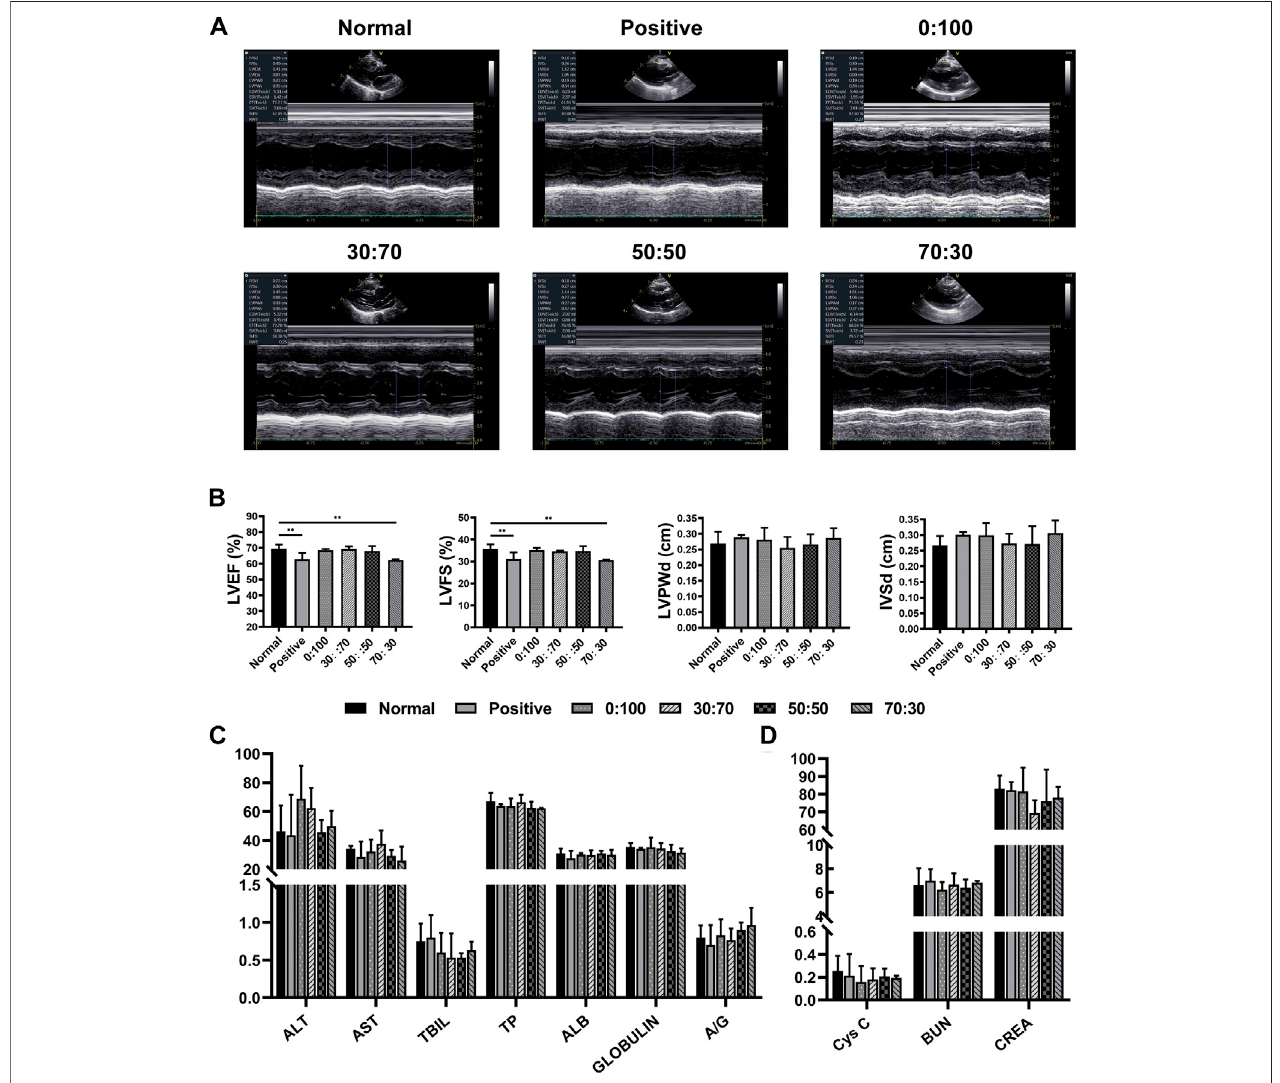
FIGURE 6 | One month after surgery (A) representative echocardiography images, (B) heart function and (C,D) liver/kidney function for normal and experimental groups. (** p < 0.01).